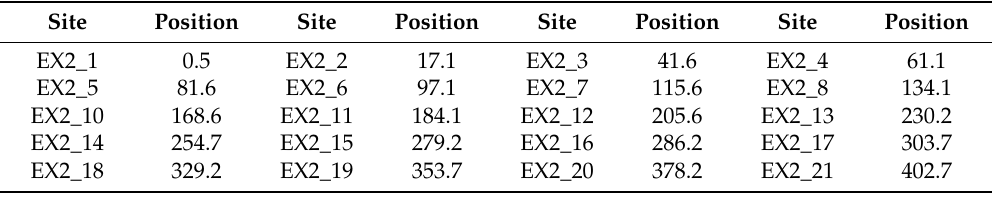
Table 2. Position information of EX2 tension wire alignment measuring points (unit: m).